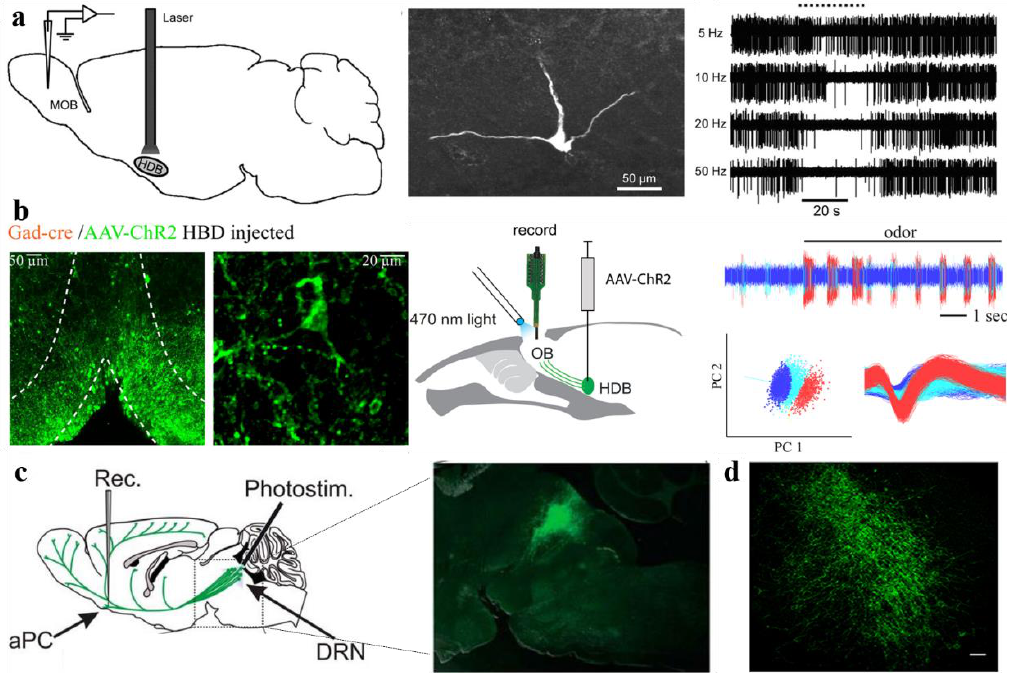
Figure 6. Optogenetic approaches in neuromodulatory inputs to the OB. ( a ) Activating HDB cholinergic neurons inhibits the spontaneous activity of M/T cells [41] . ( b ) Selective targeting of GABAergic inputs from the basal forebrain to the OB. Schematic of experimental approach and data acquisition [63] . ( c ) DRN 5-HT photostimulation suppresses spontaneous aPC activity [65] . ( d ) Optogenetic silencing of norepinephrine axons in the OB does not alter the broadband odorant- elicited change in LFP power [66] . Reproduced with permission from ( a ) [41], Copyright 2012 Society for Neuroscience;